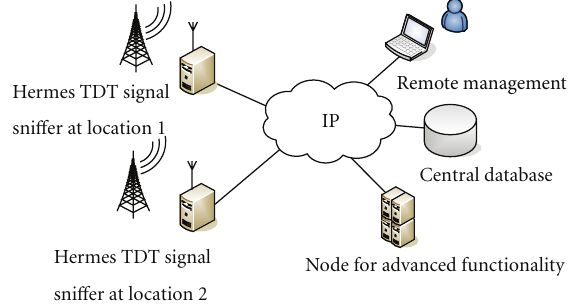
Figure 3: Hermes TDT signal sni ff